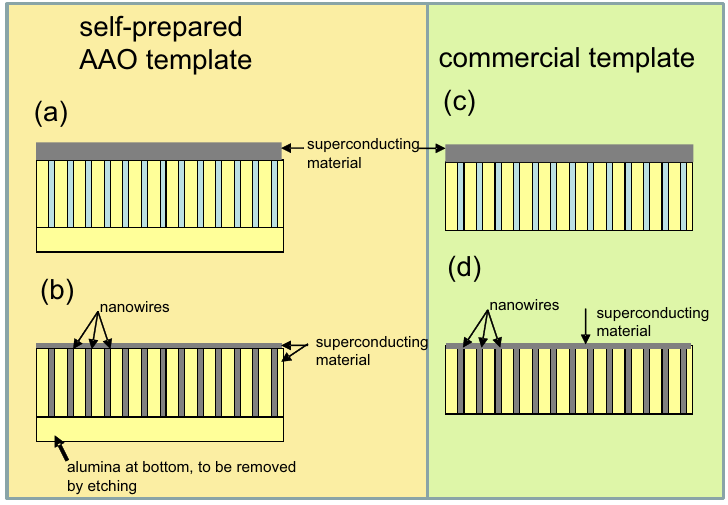
Figure 6. ( a – d ) Schematic drawing of the steps in the template technique; ( a , b ) present the situation for a self-prepared AAO template. The superconducting material (grey) is placed on top of the template (empty pores are indicated in light blue), and the pores are filled (indicated in dark gray) with the molten material. Images ( c , d ) give the situation for a commercial template. Note that, in both ( b , d ), the remaining superconducting material covers the top of the template. In ( b ), the untreated alumina bottom must also be removed after the processing, if electrical contacts to the nanowires are